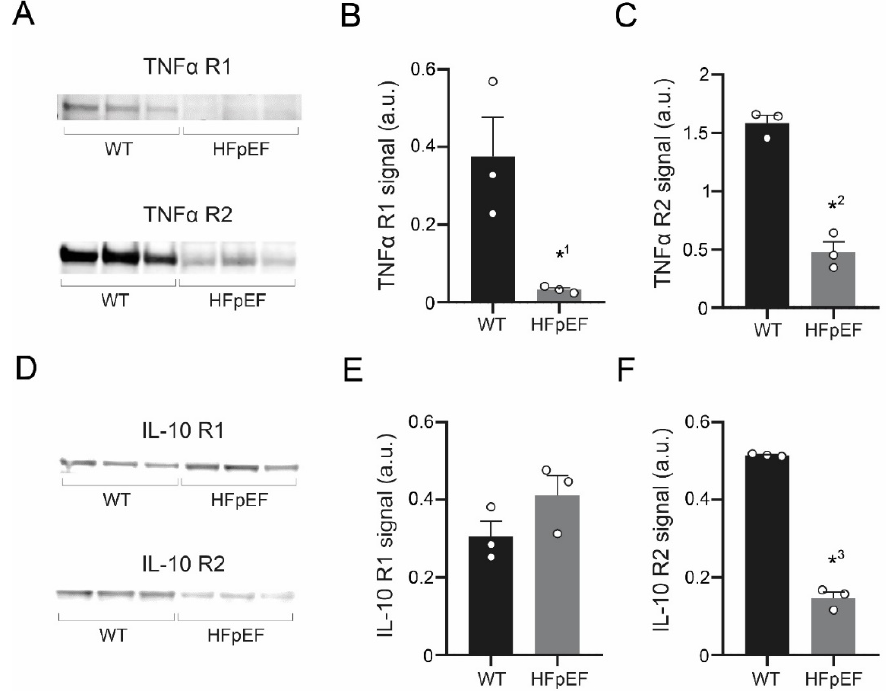
Figure 5. ( A ) Western Blot of TNF- α receptor type 1 (TNF- α R1; upper) and TNF- α receptor type 2 (TNF- α R2; lower) in left atrial myocardial tissue. ( B ) Corresponding data of TNF- α R1 and ( C ) TNF- α R2. ( D ) Western Blot of IL-10 receptor type 1 (IL-10 R1; upper) and IL-10 receptor type 2 (IL-10 R2; lower). ( E ) Corresponding data of IL-10 R1 and ( F ) IL-10 R2. Statistical analysis: Student’s t -test. p -values: * 1 0.027, * 2 0.0005, * 3 < 0.0001. n -numbers indicate animals.